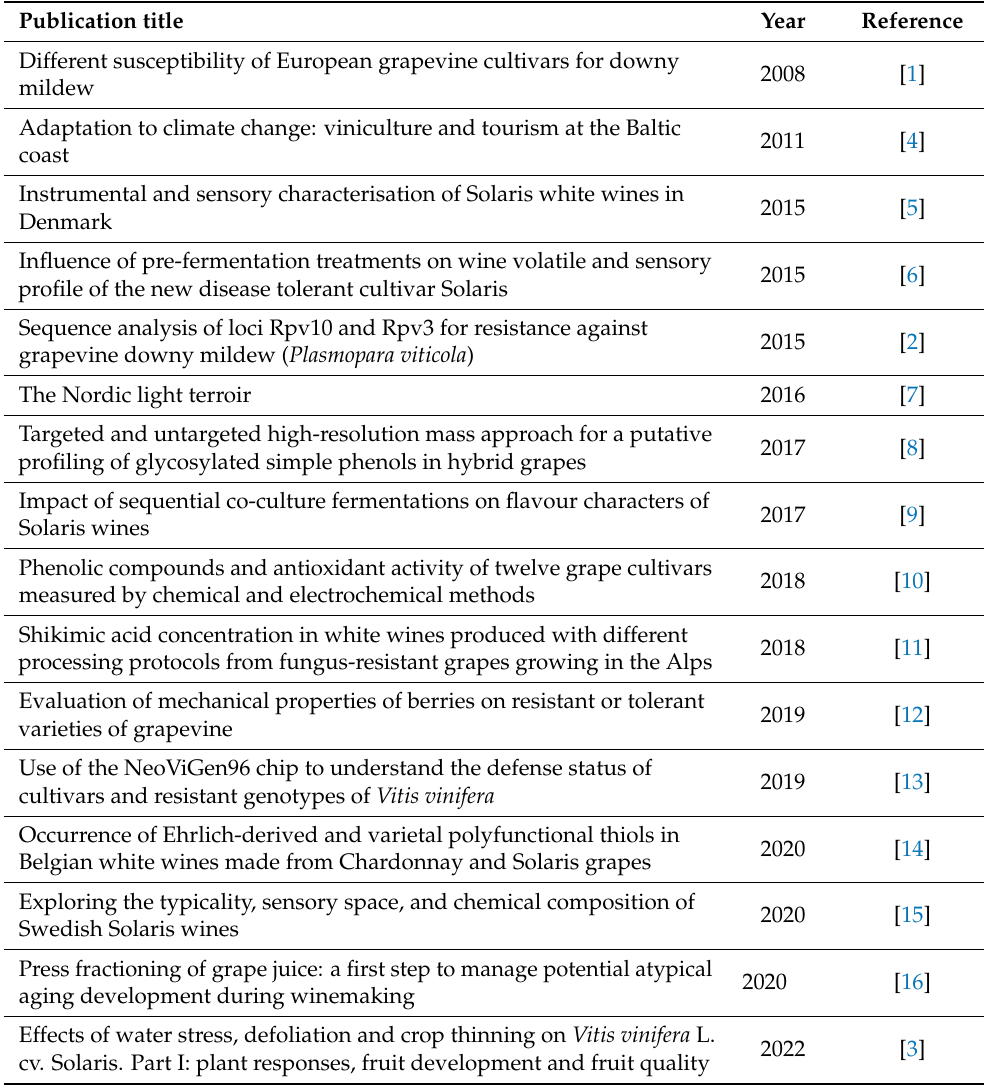
Table 1. Studies on Solaris grape and wines per year 2000–2022. Web of Science was used to search for publications using “Solaris”, “grape”, and “wine” as topic